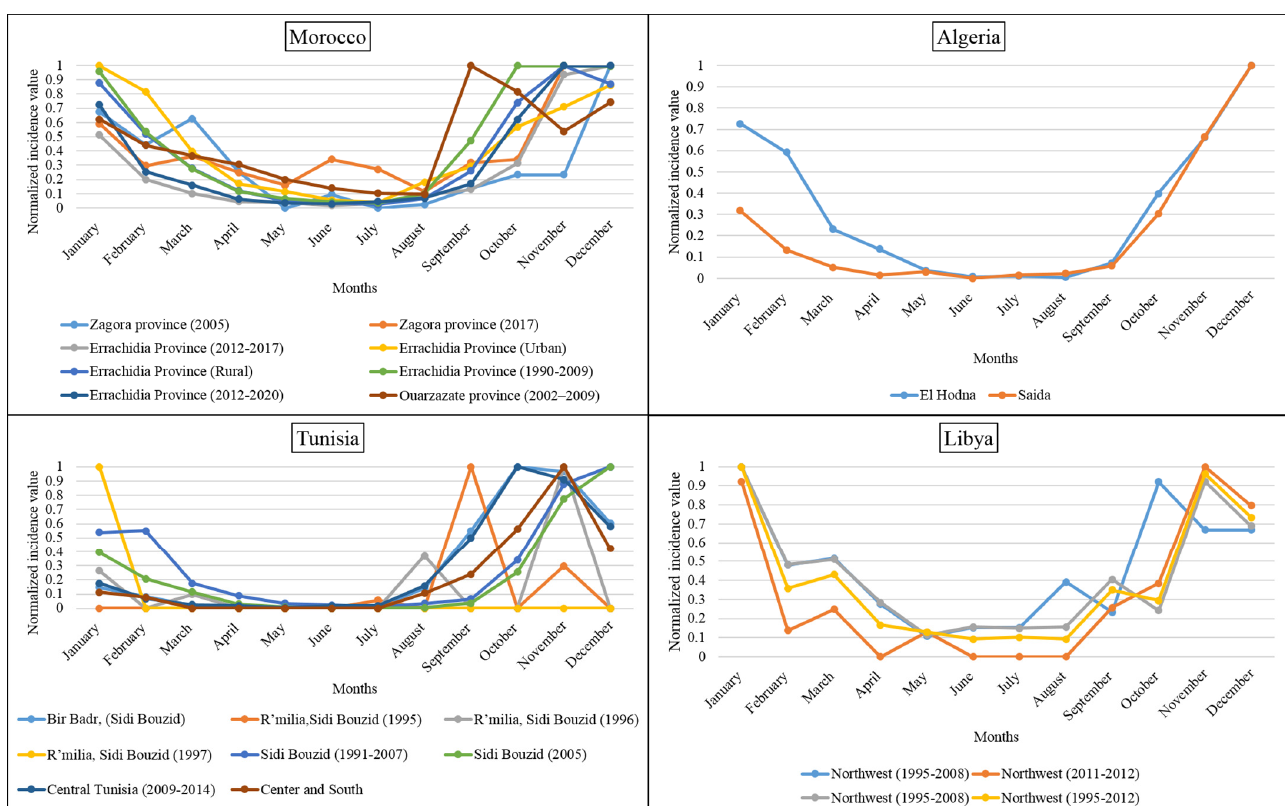
Figure 5. Seasonal distribution of ZCL cases, total values of all sites of the North African region.